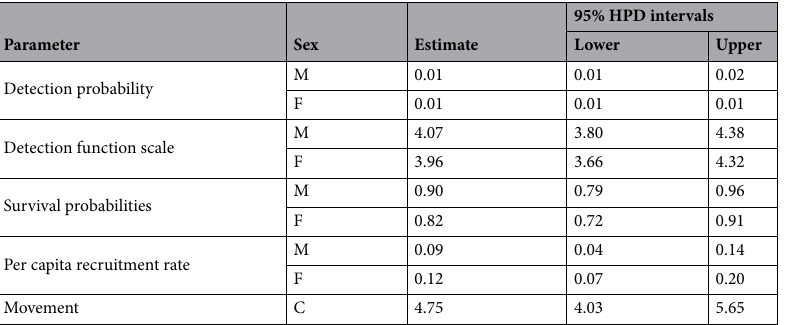
Table 2. Posterior modes and 95% highest posterior density (HPD) intervals of open population spatial capture–recapture (SCR) model referring to male (M) and female (F) lynx yearly baseline detection probability g 0 , detection function scale σ (km), survival probabilities and per capita recruitment rate. Per capita recruitment rate indicates the number of individuals of each sex added per year per total abundance. The yearly movement (km) was calculated for sexes combined